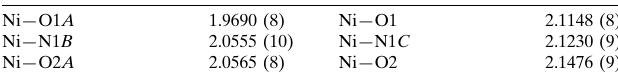
Selected geometric parameters (A˚ , (cid:3) ).